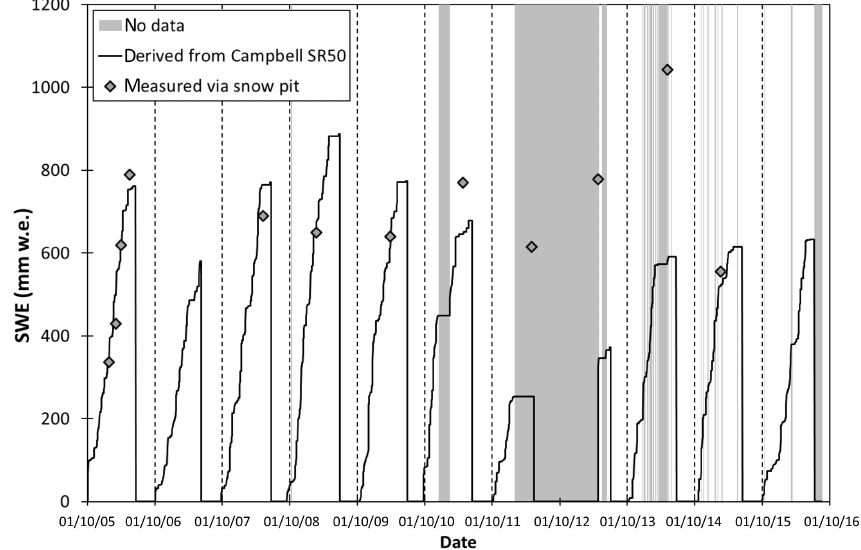
Figure 3. Daily SWE data derived from snow depth by the Campbell SR50 (using the new snow density of 149kgm − 3 ) and measured by snow pits from 1 October 2005 to 30 September 2016. The periods without data are shown in light grey. The dates shown are dd/mm/yy.